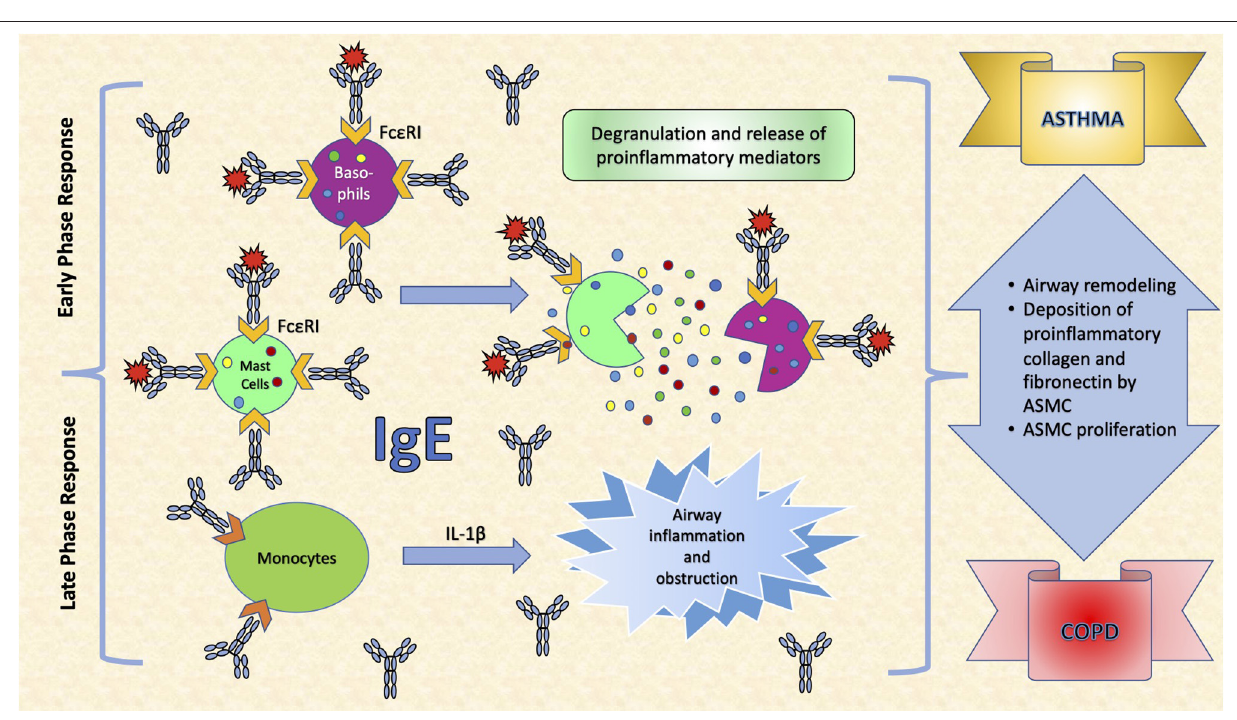
inflammatory mechanism that includes allergic sensitization and Th2-mediated immune airway responses (5). COPD, on the other hand is mainly considered a Th1-mediated inflammatory process